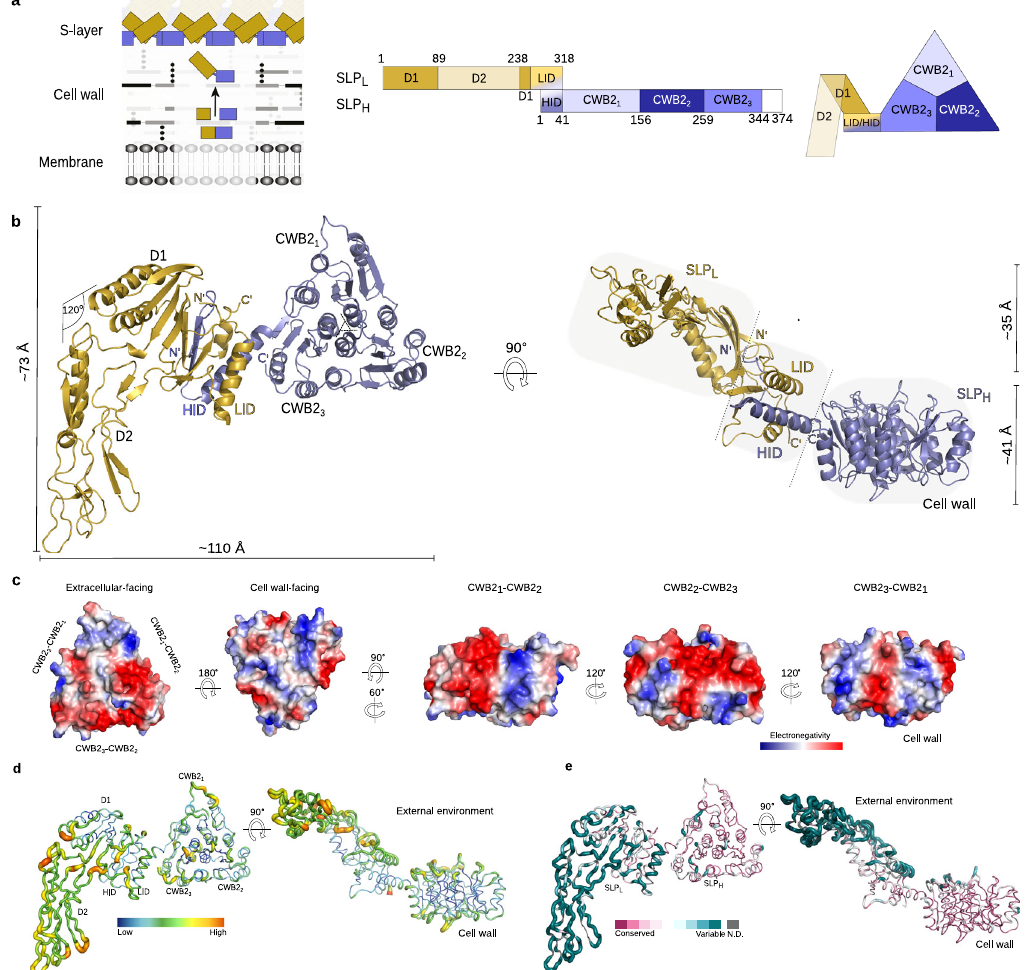
Fig. 1 Architecture of C. dif fi cile SLP H /SLP L (H/L) complex. a SlpA arrangement on the cell surface (left; SLP L coloured in gold and SLP H in slate blue) with detailed organisation of protein building blocks in its primary sequence (middle) and quaternary structure (right). Numbering based on the subunits of SlpA from strain CD630, S-layer cassette type 7 (SLCT-7), PBD ID: 7ACY. b Cartoon representation of H/L complex as viewed from the external environment (top view, left) and side (right). The SLP L protrudes above the SLP H subunit, creating a two-plane arrangement. Three distinct structural features are observed: SLP H , D1 and D2, and LID/HID (regions highlighted in grey). c Charge distribution across CWB2 motifs in SLP H as Poisson – Boltzmann electrostatic potential calculated for SlpA CD630 , shown as a gradient (positive in blue to negative in red). Views are shown from the extracellular and cell wall surfaces, followed by side views of the lateral faces de fi ned by two interacting CWB2s. d Putty representations of SlpA CD630 H/L complex showing B-factors ranging from low (blue and narrow) to high (red and wide). High B-factors are indicative of disorder/ fl exible regions. e Conservation of the SlpA sequence across annotated SlpA cassette types (SLCTs) depicted on putty representations of SlpA CD630 H/L complex, coloured from conserved (purple) to variable (cyan). Conservation was calculated using Consurf web